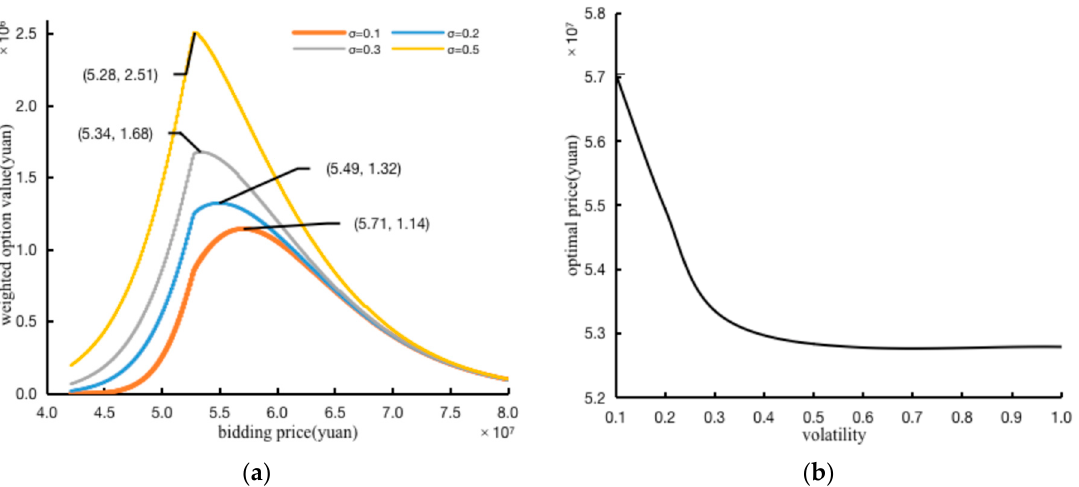
Figure 4. Sensitivity analysis of volatility. ( a ) Volatility sensitivity; ( b ) Fluctuation trend of optimal price. ( C t = 50,000,000; b = 10; n = 1.1; u = 0.3; r = 0.01; T-t = 0.5; N = 50; AP comps = 52.79 million).